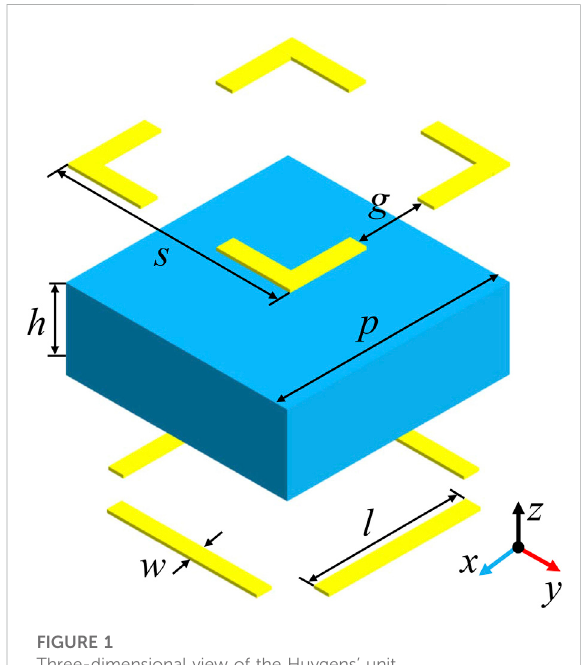
FIGURE 1 Three-dimensional view of the Huygens ’ unit.